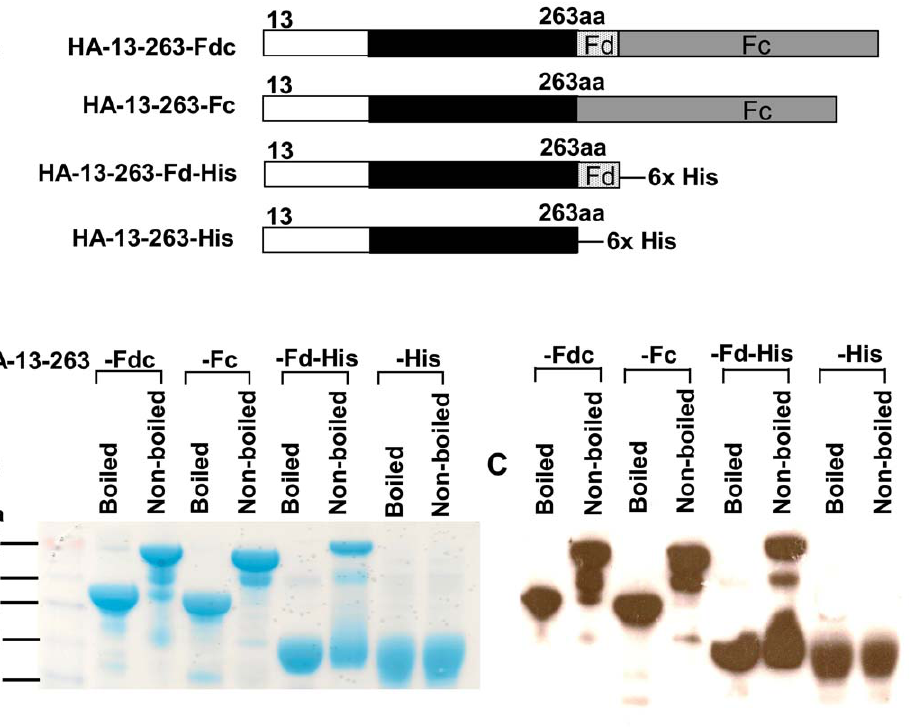
Figure 4. Construction of protein fragments containing HA-13–263 with or without Fd or Fc and analysis of protein expression. (A) Proteins containing residues of HA-13–263 with Fc (HA-13–263-Fc), with Fd (HA-13–263-Fd-His), or without fusion with Fd and Fc (HA-13–263-His) were constructed. Purified proteins were either boiled at 95 u C for 5 min, or not boiled, followed by detection of the expression by SDS-PAGE and Coomassie Blue staining (B), and Western blot (C) by using a HA1-specific mAb. The protein molecular weight marker (kDa) (Invitrogen) is indicated on the left.